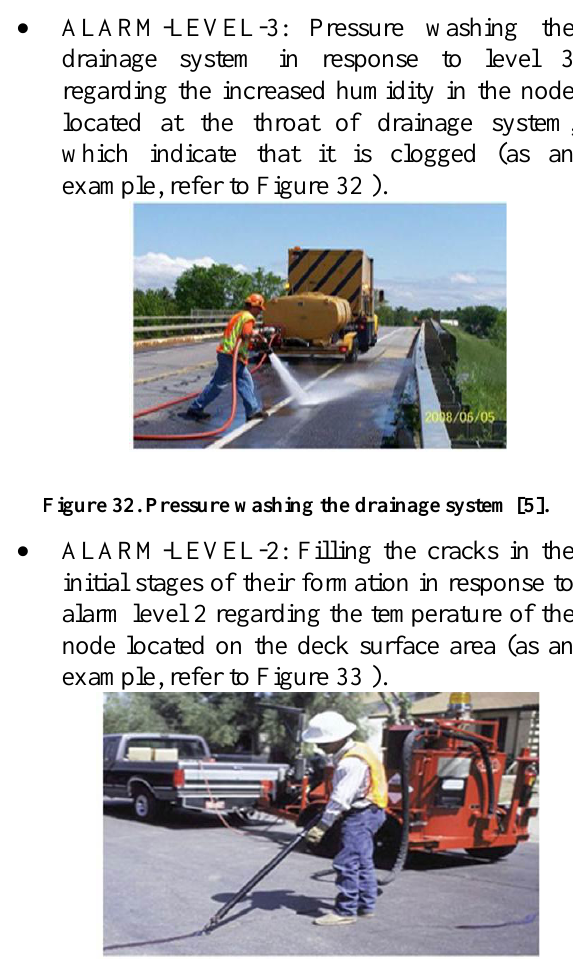
Figure 33. Filling cracks in initial stages of their formation